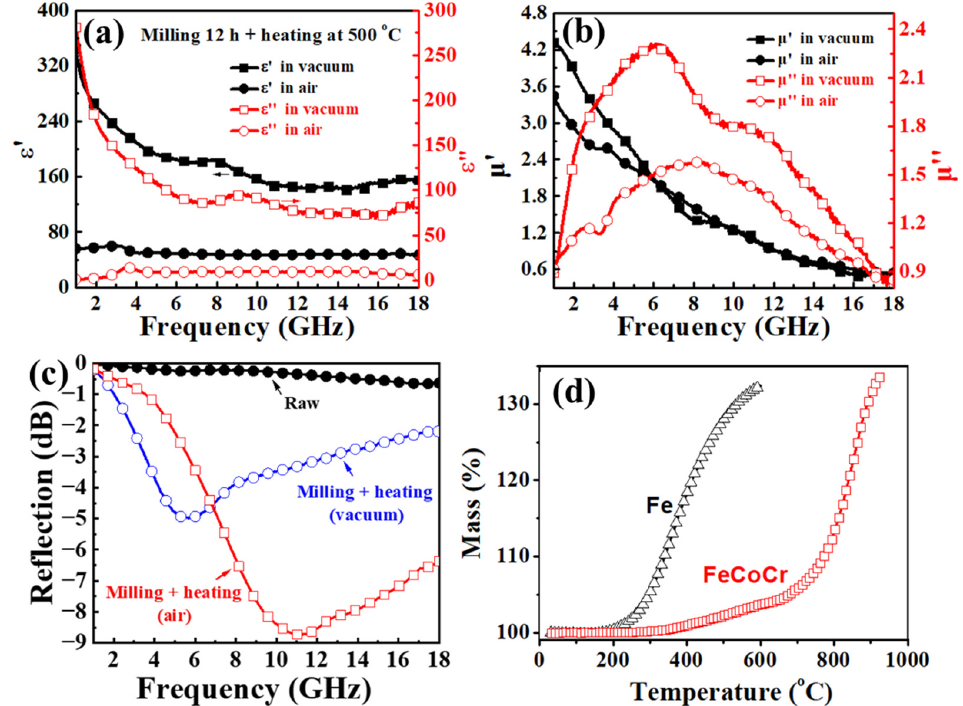
Figure 4. ( a ) Complex permittivity, ( b ) complex permeability and ( c ) simulated RL of FeCoCr powders after ball milling and subsequent heat treatment in vacuum or air; ( d ) Thermogravimetry spectra of Fe and FeCoCr powders.